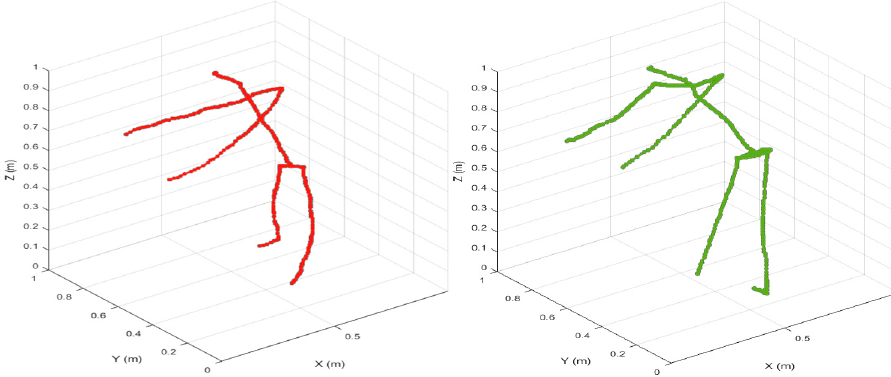
Figure 15. Pose estimation of bending position.